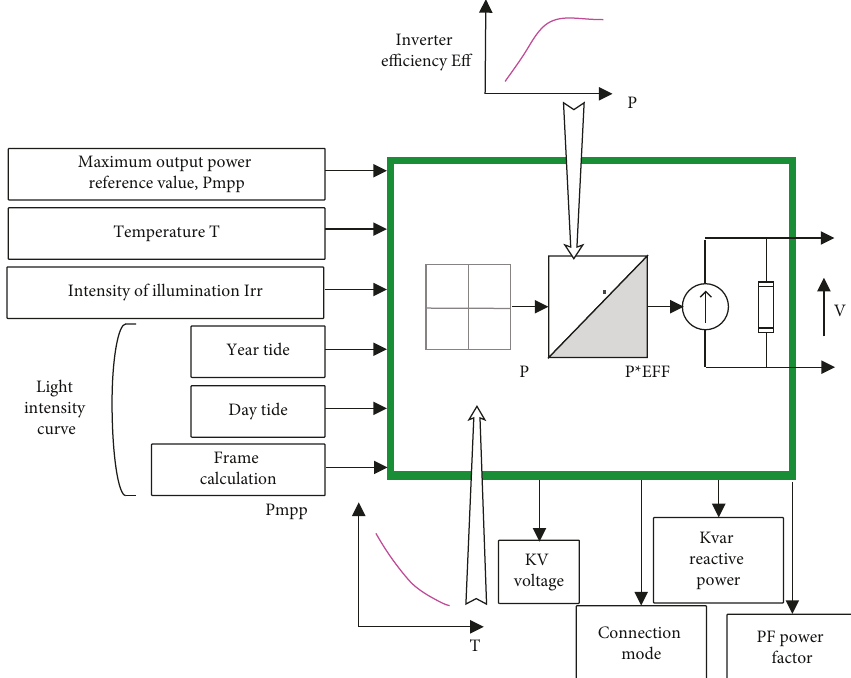
Figure 4: Definition of the photovoltaic power model in